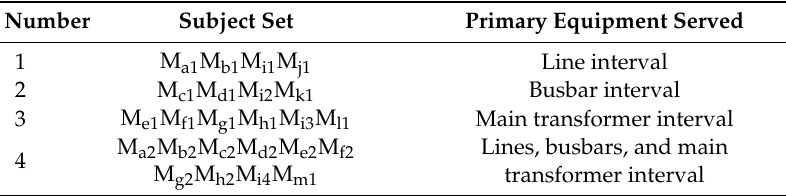
Table 5. Composition of protection function agent set.